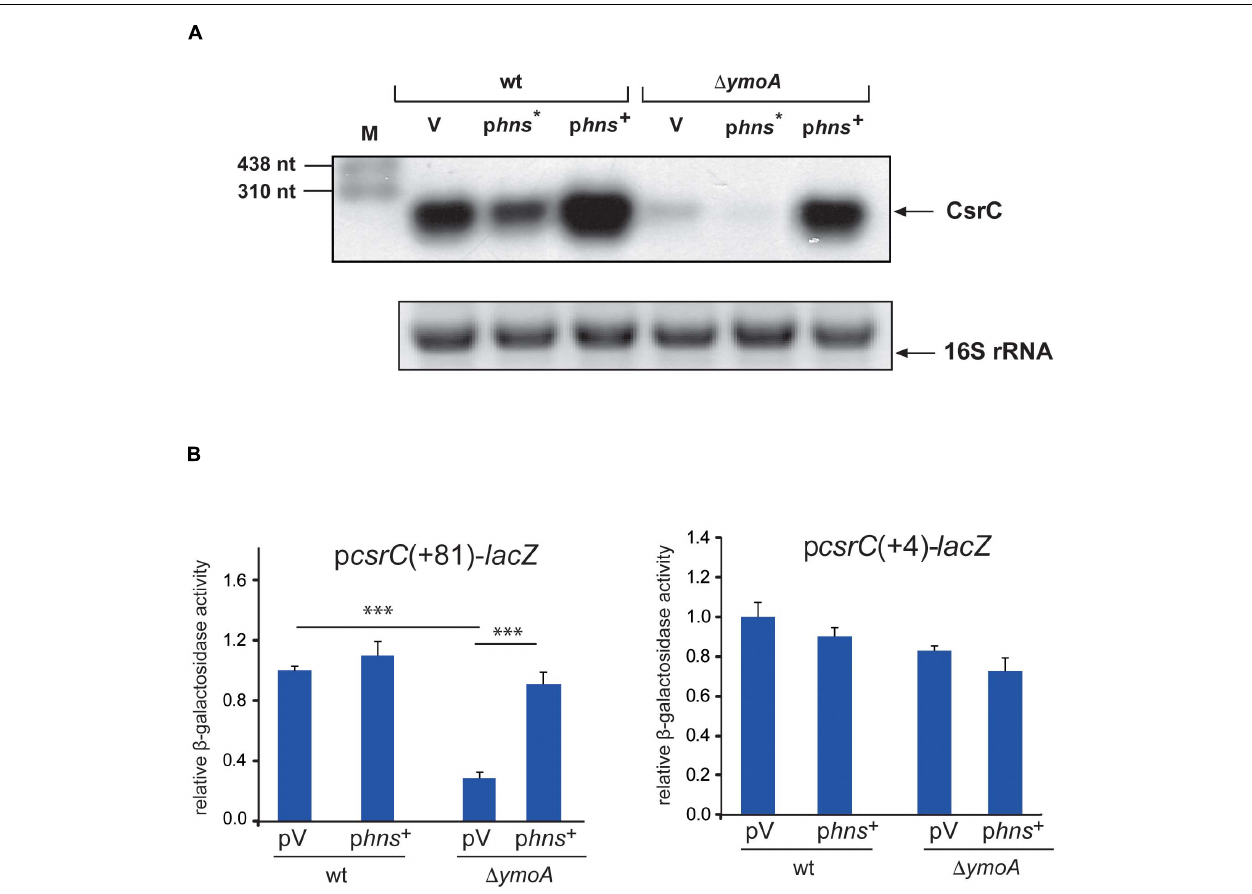
FIGURE 7 | H-NS has a positive influence on csrC . (A) Y. pseudotuberculosis strain YPIII and YP50 ( (cid:49) ymoA ) harboring the empty vector (V), a hns* (pAKH31) or hns + (pAKH74) overexpression construct were cultivated overnight in LB medium at 25 ◦ C. Total RNA of the strains was prepared, separated on agarose gels and a specific probe was used to detect the CsrC RNA by Northern blotting. The 16S rRNA is shown as RNA loading control. (B) Expression of csrC (+4)- lacZ and csrC (+81)- lacZ was analyzed in overnight cultures of Y. pseudotuberculosis strains YPIII (wild-type) and YP50 ( (cid:49) ymoA ) harboring vector pACYC184, pAKH85 or its hns + derivative pAKH74 grown in LB at 25 ◦ C. β -galactosidase activity from the overnight cultures was determined and is given as relative expression for comparison. The data represent the average ± SD from at least three different experiments each done in duplicate. Data were analyzed by the ANOVA test, ∗∗∗ P <